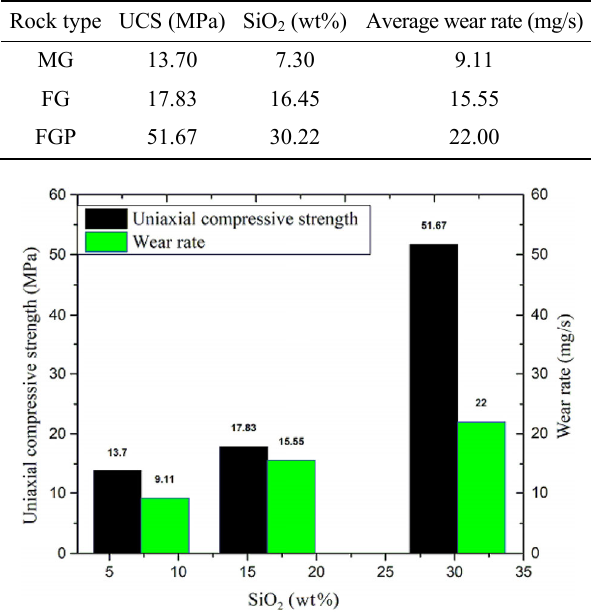
Table 4 Average wear rate of drill bit corresponding to UCS and SiO 2 of the rock samples.